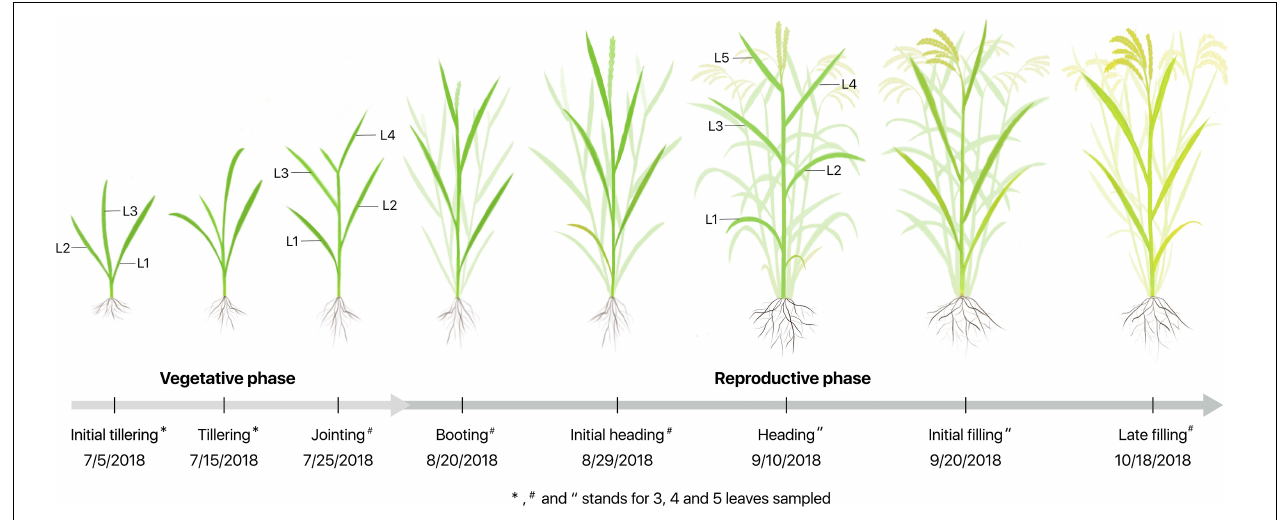
FIGURE 1 | Schematic diagram for sampling and measurements from the initial tillering to the late filling stages during vegetative and reproductive phases. L1–L5 represent the leaf position from bottom to top of the plant, and V1–V3 and R1-R5 are related to eight growth stages, respectively.